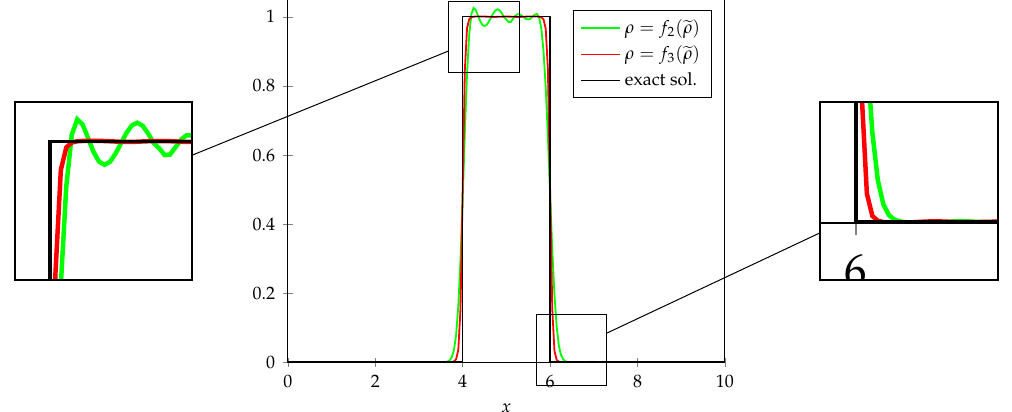
Figure 6. Square density wave advection—density field after one period ( t = 10) obtained using the exponential and the hyperbolic tangent-based change of density variable at density ratio r ρ = 800. DG polynomial approximation of degree k = 6 on a uniform mesh of 10 × 1 square